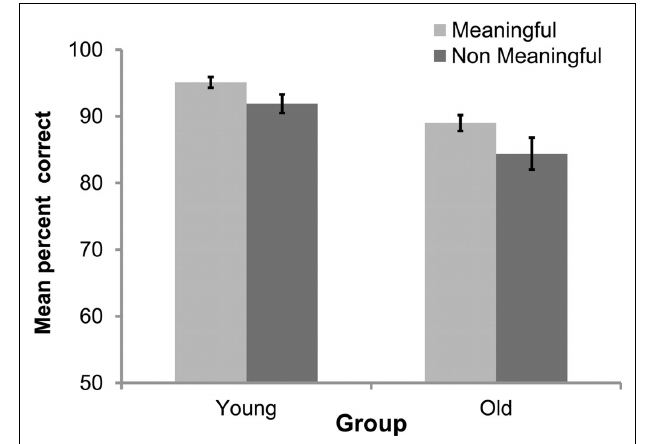
FIGURE 2 | Mean percent correct for discrimination of meaningful and non-meaningful sentences for both younger and older adult